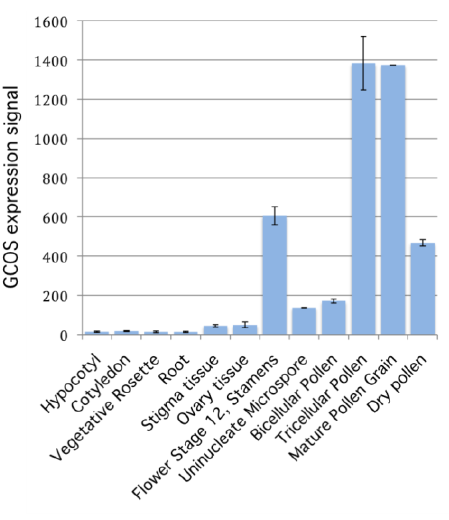
Figure 5. Detection of PIRL6 transcripts in reproductive tissues, gametophytes, and representative vegetative organs. Data originated from multiple published microarray experiments (see Table 2) and was accessed via the Arabidopsis eFP browser